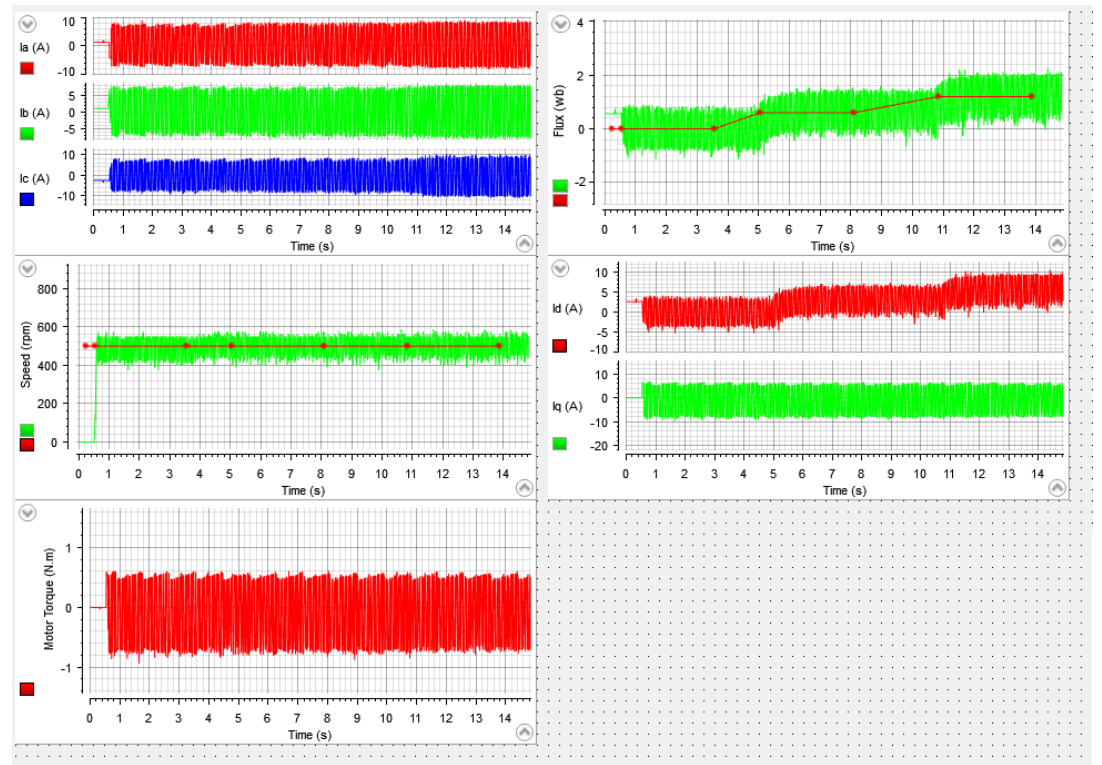
Figure 11. The PMSM performance at flux change.